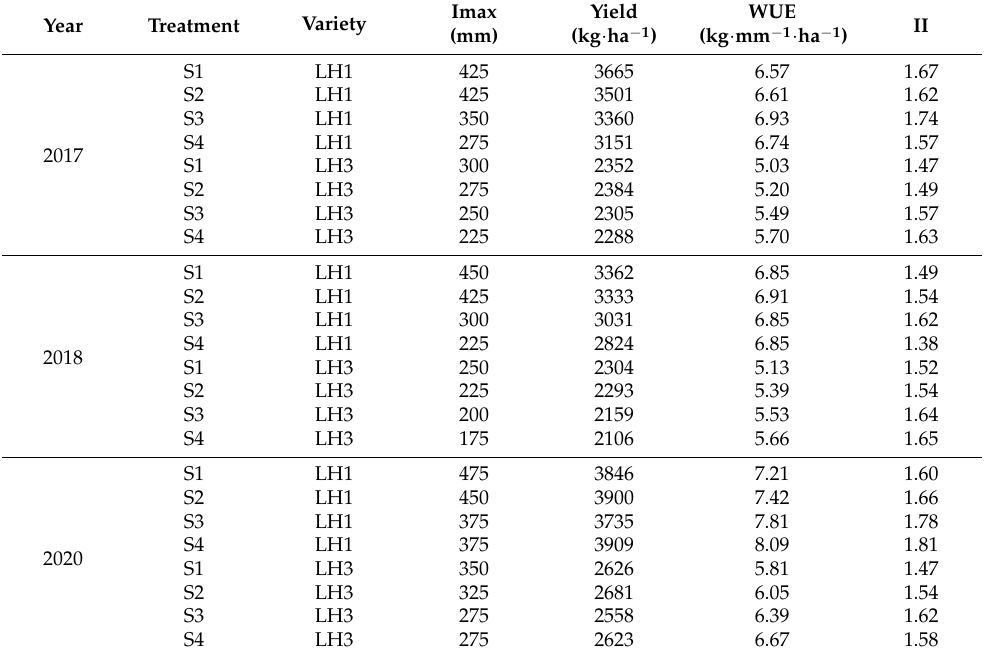
Table 7. The maximum yield, WUE and II of different Irrigation schedules for LH1 and LH3 under corresponding hydrological conditions.